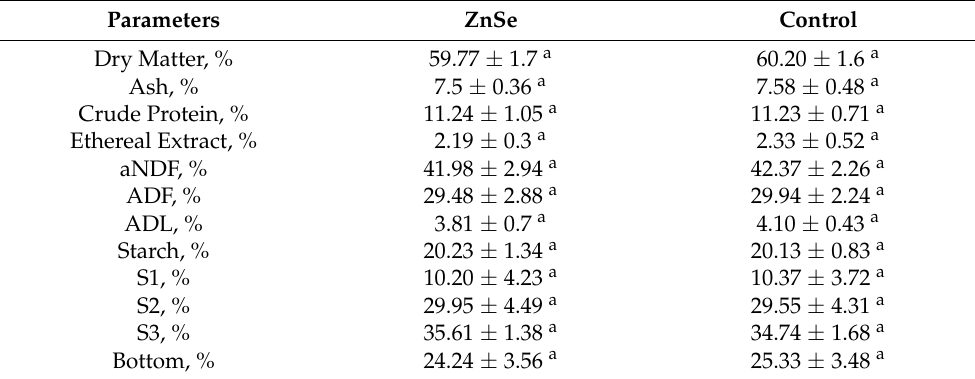
Table 3. Characteristics of total mixed ratio (TMR) distributed to the two experimental groups. Data are expressed as Lsmeans ± SE. a Same letters indicate no significant differences.